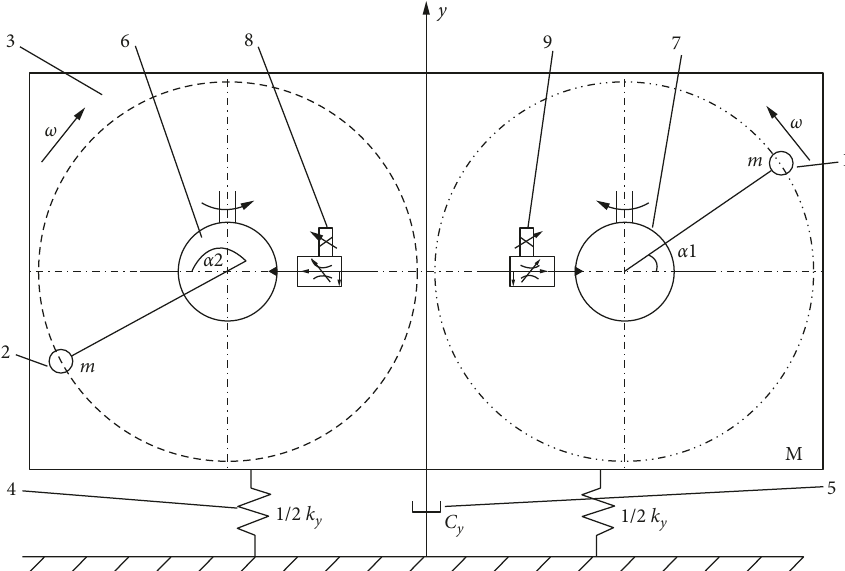
Figure 1: New vibration piling hammer-soil model. (1), (2) Eccentric blocks 1 and 2. (3) Pile hammer body. (4) Foundation soil’s flexibility. (5) Foundation soil’s damping. (6), (7) Hydraulic motors 6 and 7. (8), (9) Electrohydraulic proportional valves 8 and 9.